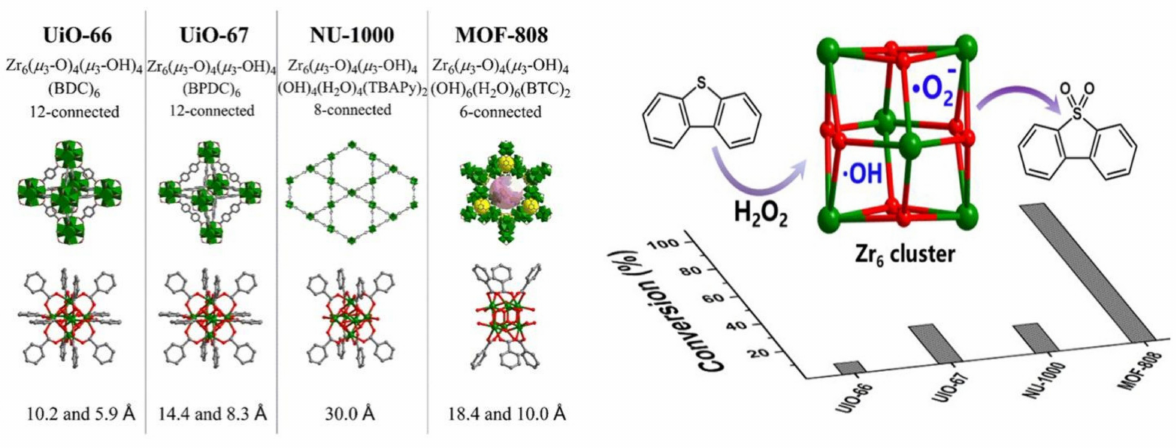
Figure 3. The structure of various Zr-MOFs and their catalytic oxidation performance (adapted from Ref. [48], copyright 2019 American Chemical Society). Table 2. Comparison of catalytic performance over various Zr-MOFs in the ODS reactions of model fuel oil.